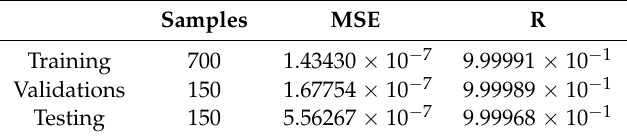
Figure 9. Neural network training regression: ( a ) The regression diagram of the 70% group of the training data; ( b ) The regression diagram of the 15% group of the validation data; ( c ) The regression diagram of the 15% group of test data; ( d ) The regression diagram of all data. Table 1. The results of the prediction with the artificial neural networks